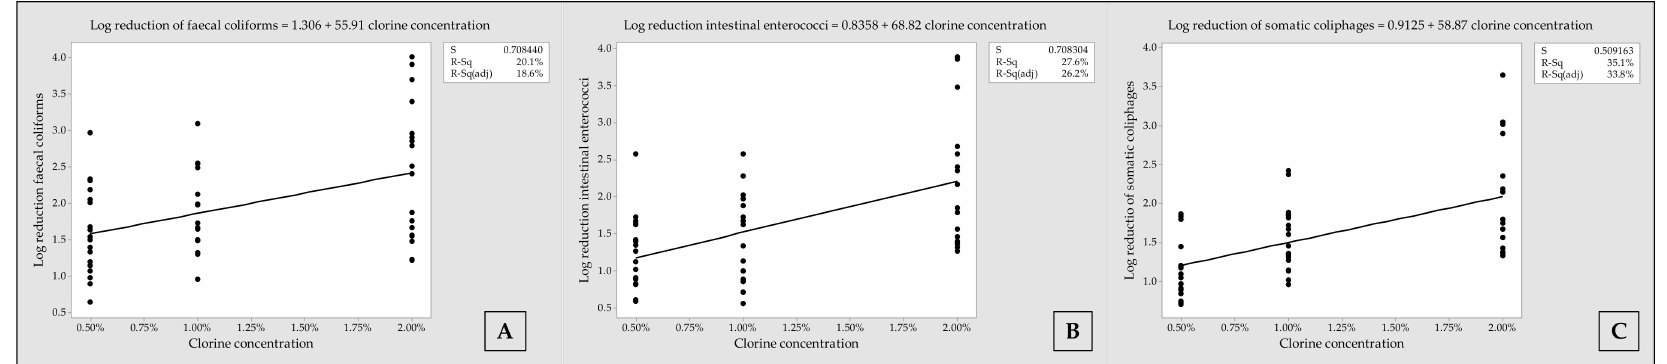
Figure 4. Fitted line plots with regression equations, representing the log reduction of faecal coliforms ( A ), intestinal enterococci ( B ), and somatic coliphages ( C ), according to chlorine